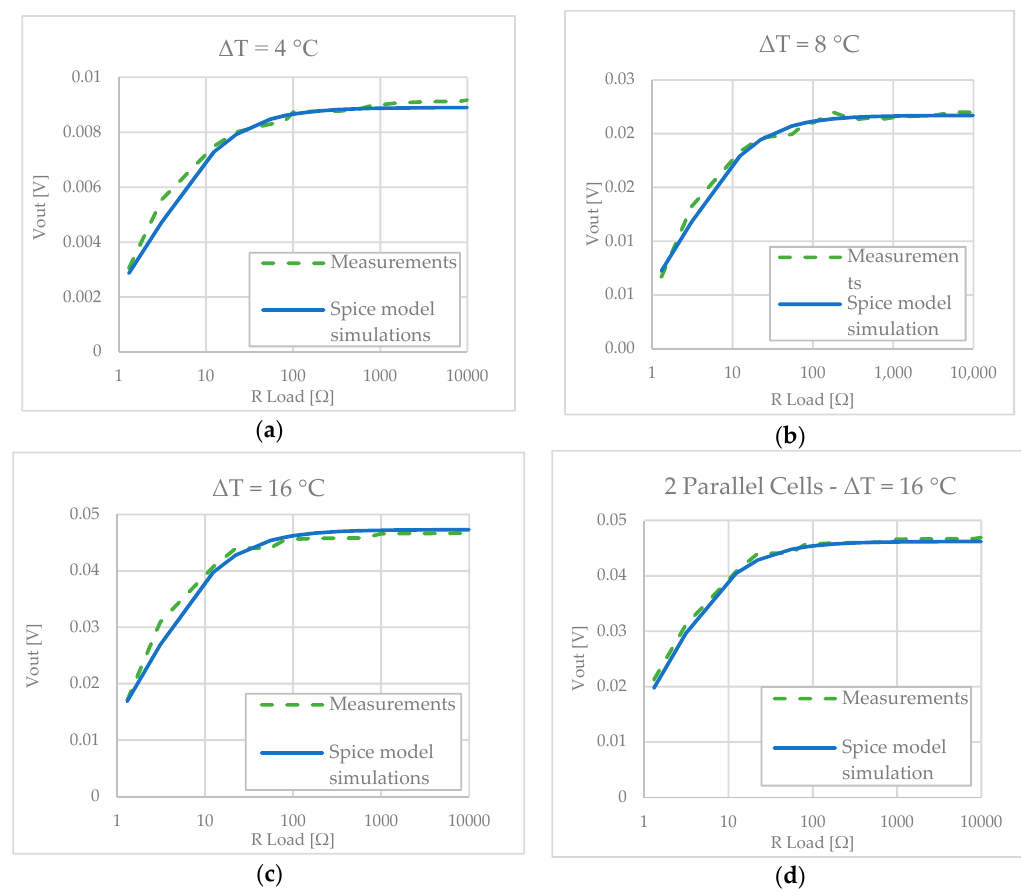
Figure 7. Comparison of the obtained SPICE model: ( a ) single cell at Δ T = 4 °C, ( b ) single cell at Δ T = 8 °C, ( c ) single cell at Δ T = 16 °C, and ( d ) two parallel cells at Δ t = 16 °C.